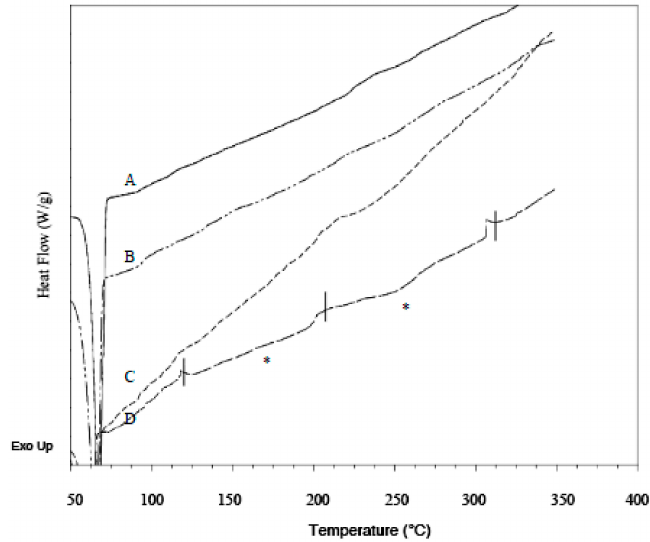
Figure 8. DSC thermograms of in situ loaded DIC formulations. ( A ) PEO-DIC 3.17% w / w , ( B ) PEO-DIC 8.37% w / w , ( C ) PEO-DIC 13.12% w / w , ( D ) PEO-DIC 20.26% w / w . Melting endotherms are marked with asterisks